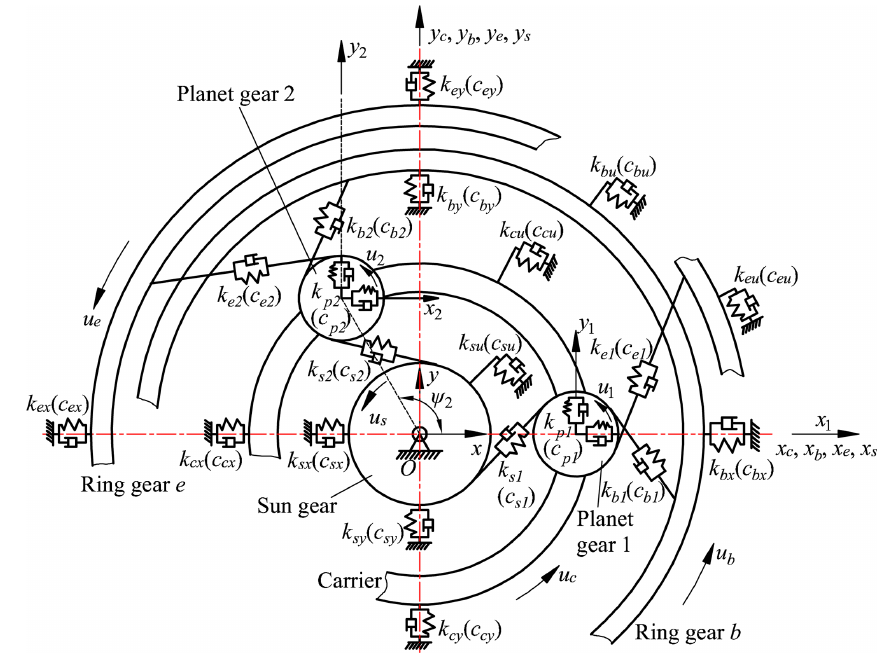
Figure 2. Dynamic model of a 3K-II planetary gear